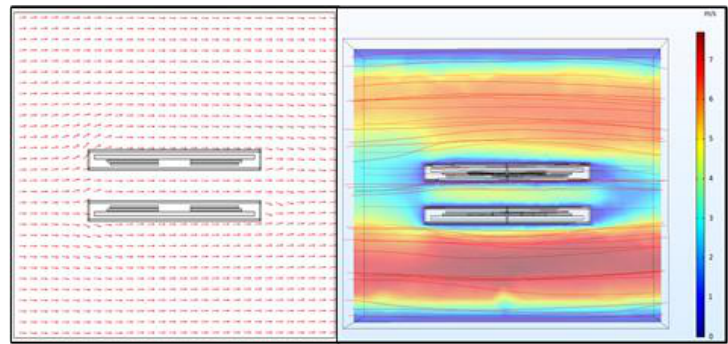
Figure 10. Laminar flow distribution map.